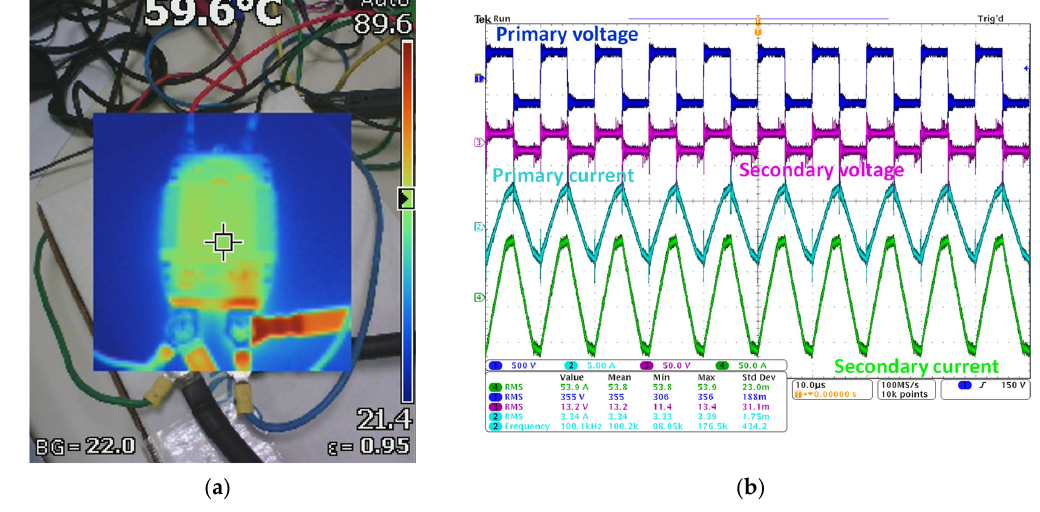
Figure 13. Thermal characterization—350 V (primary)/53.9 A (secondary): ( a ) temperature distribution; ( b ) voltage and current waveforms.